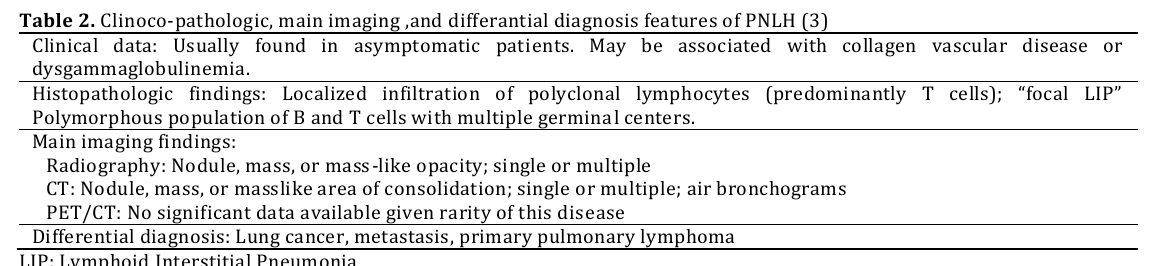
Table 2. Clinoco-pathologic, main imaging ,and differantial diagnosis features of PNLH (3) Clinical data: Usually found in asymptomatic patients. May be associated with collagen vascular disease or dysgammaglobulinemia. Histopathologic findings: Localized infiltration of polyclonal lymphocytes (predominantly T cells); “focal LIP” Polymorphous population of B and T cells with multiple germinal centers. Main imaging findings: Radiography: Nodule, mass, or mass-like opacity; single or multiple CT: Nodule, mass, or masslike area of consolidation; single or multiple; air bronchograms PET/CT: No significant data available given rarity of this disease Differential diagnosis: Lung cancer, metastasis, primary pulmonary lymphoma LIP: Lymphoid Interstitial